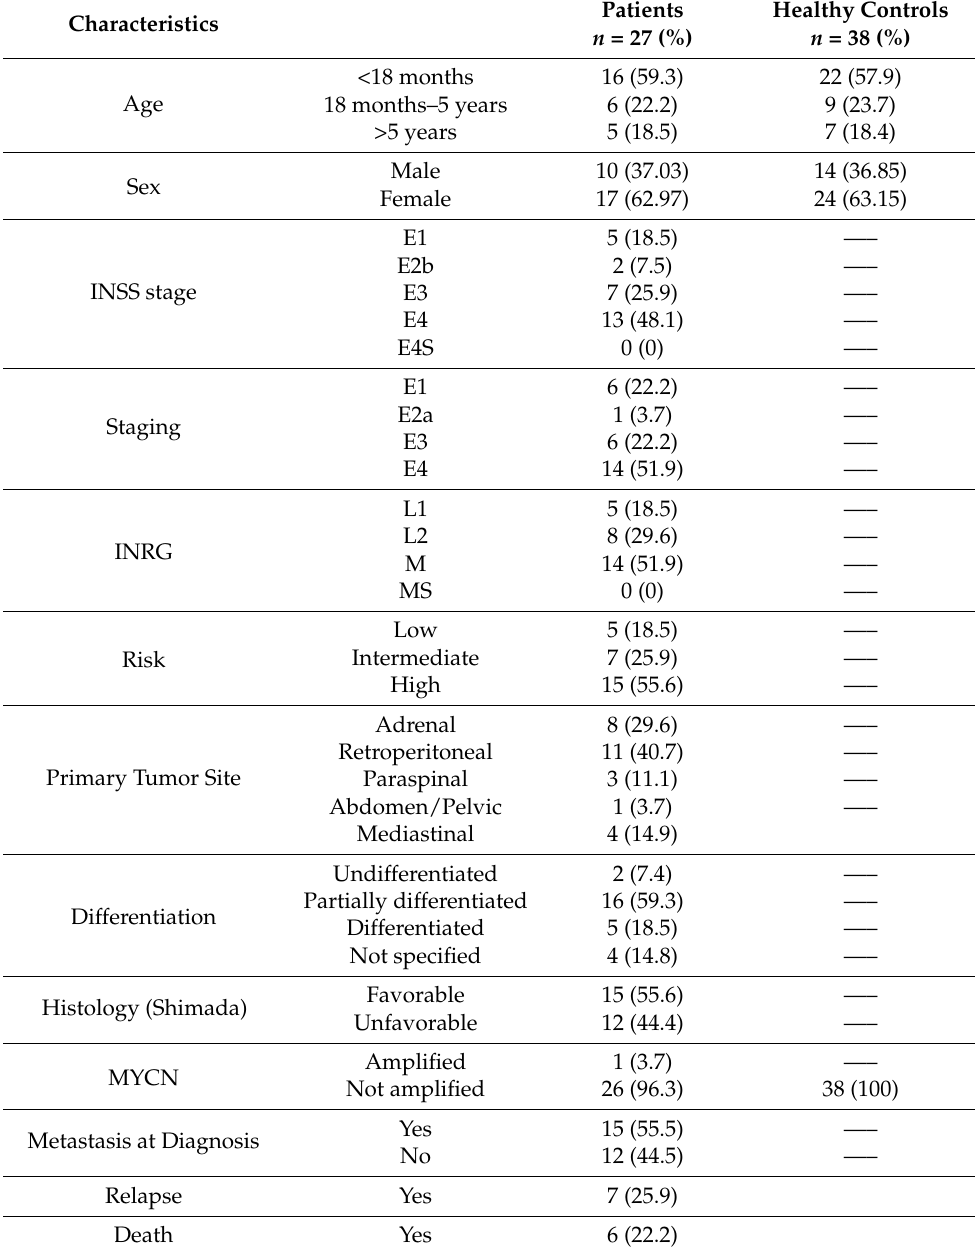
Table 1. Characteristics of neuroblastoma (NB) patients and healthy